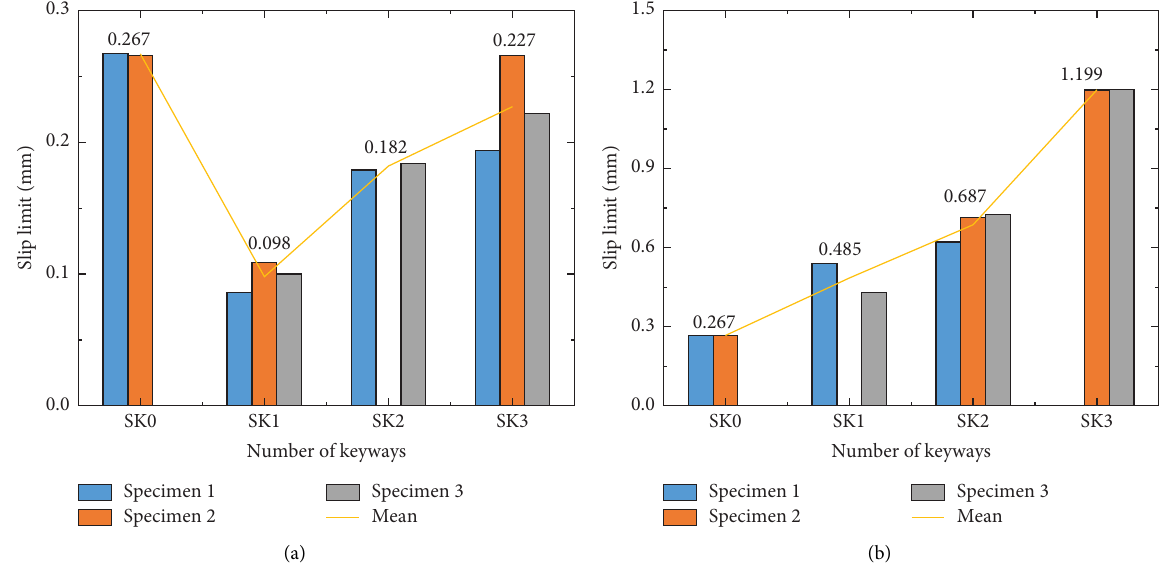
Figure 13: Interfacial slip with diferent interfacial agents. (a) Te interface slip stage. (b) Te keyway strengthening